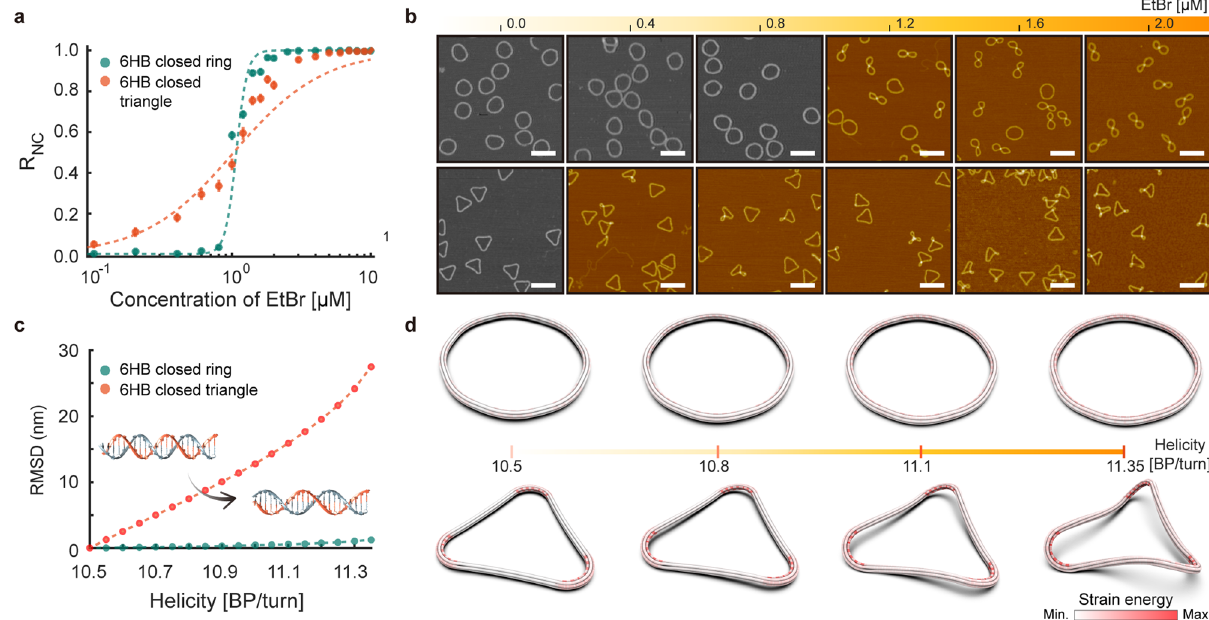
Fig. 4 Differences in the recon fi guration responses between rings and triangles. a R NC values as a function of EtBr concentration. Circles and error bars represent the means and the standard deviations of experimentally measured R NC values, respectively. Dashed lines represent the fi tted Hill curves. b AFM images of 6HB closed rings (top) and triangles (bottom). Scale bars in the AFM images represent 200 nm. c Root-mean-squared displacement (RMSD) of 6HB closed rings (green) and triangles (red) predicted by FE analysis. RMSD was calculated for structures with perturbed helicities with respect to the reference structure exhibiting a helicity of 10.5 BP/turn. d Simulated conformations of 6HB closed rings (top) and triangles (bottom). The color bar represents the strain energy stored in